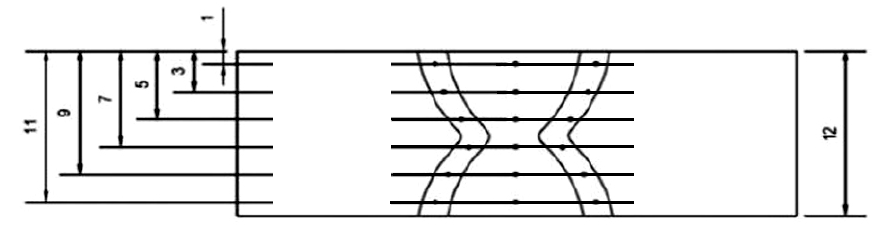
Figure 4. The distribution of Vickers HV10 hardness measurement points in the specimens.